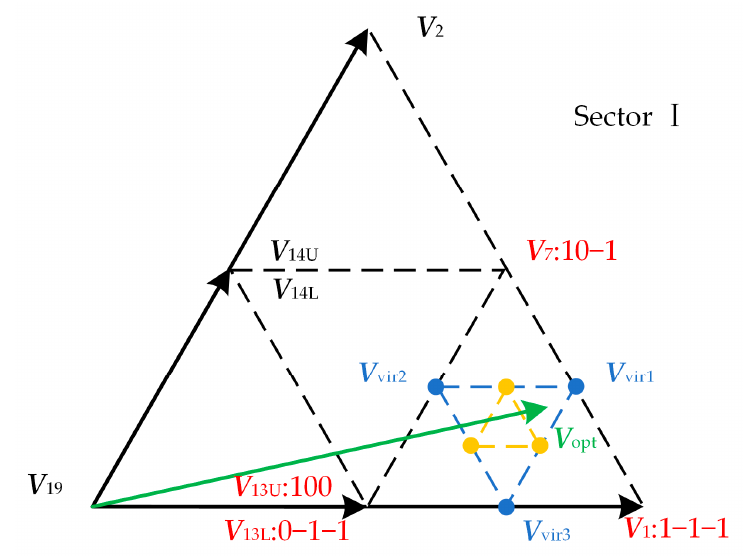
above three vectors. The current prediction values corresponding to each virtual vector can be calculated directly from the current prediction values corresponding to V 1 , V 7 , and V 13 by using (15). By adding the calculation results to the optimization search process, the vectors closer to the optimal vector can be found as V vir1 , V vir2 , and V vir3 . If the virtual vectors are continuously synthesized in the above way and added to the calculation process, the three optimal vectors can also be updated. By repeating the whole process M times, the minimum value function can be updated and the region where the optimal voltage vector is located can be reduced. Figure 6 is the flow chart for searching the optimal vector rapidly after screening small vectors.